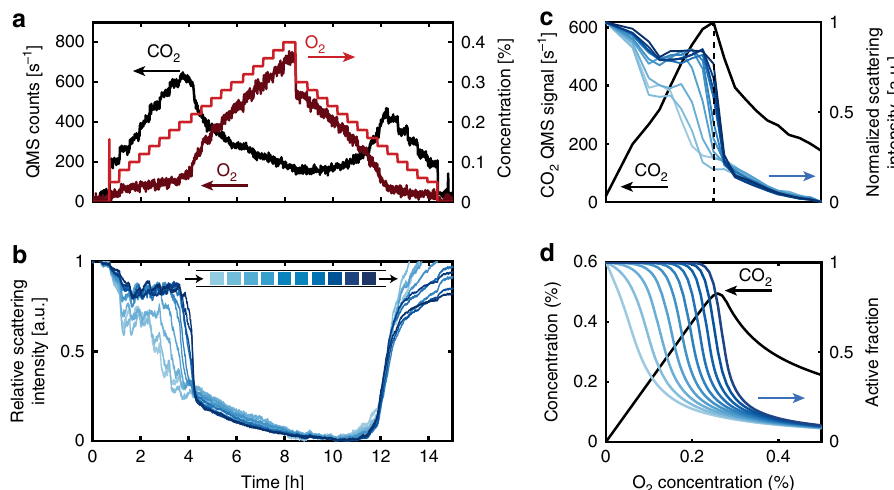
Fig. 5 CO oxidation experiments over Cu catalysts in the plug- fl ow reactor. During the entire experiment, the nominal inlet CO concentration was held constant at 7%, Ar was used as the carrier gas and the pressure at the inlet was 4 bar. a Time trace of the nominal O 2 inlet concentration in the gas feed (red) and of the outlet concentration of CO 2 (black) and O 2 (dark red) measured by the QMS. b Integrated scattering intensity time evolution of the ten Cu nanoparticle patches, each comprised of 100 nanoparticles. Inset is a schematic of the reactor with the nanoparticle array patches color-coded in blue with respect to their position in the bed. Arrows indicate fl ow direction. c Measured CO 2 outlet concentration (black) and integrated patch scattering intensity (blue) plotted as a function of the nominal inlet O 2 concentration during O 2 concentration increase in the feed. d CO 2 production and active catalyst fraction simulated with a microkinetic model using ten CSTRs in